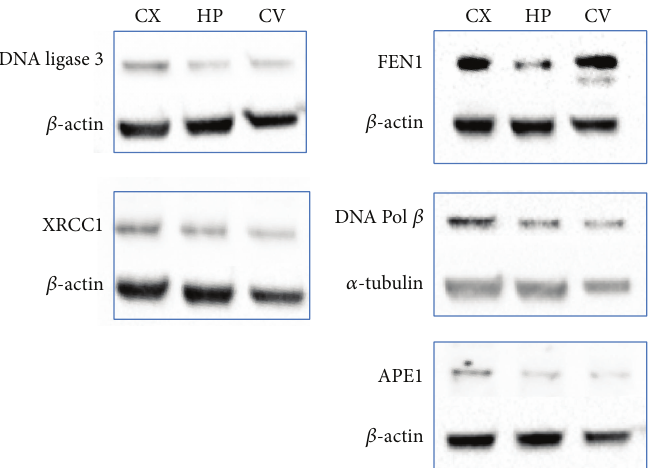
Figure 4: Levels of BER enzymes in neurons derived from cortex (CX), hippocampus (HP), and cerebellum (CV). Immunoblotting was carried out by using antibodies specific for DNA ligase 3 (103 kDa, BD Biosciences Pharmingen, San Diego, CA), FEN1 (43kDa, Abcam, Atlanta, USA), XRCC1 (85 kDa, Bethyl Laboratories, Inc.), APE1 (35.5 kDa, Santa Cruz Biotechnology, Inc.), and DNA Pol 𝛽 (38kDa, Trevigen Inc., Gaithersburg, MD). 𝛽 -actin (40kDa, Sigma) and 𝛼 -tubulin (55 kDa) were used as loading controls. Western blot analysis was conducted on 15 𝜇 g of whole cell extracts. One representative experiment is